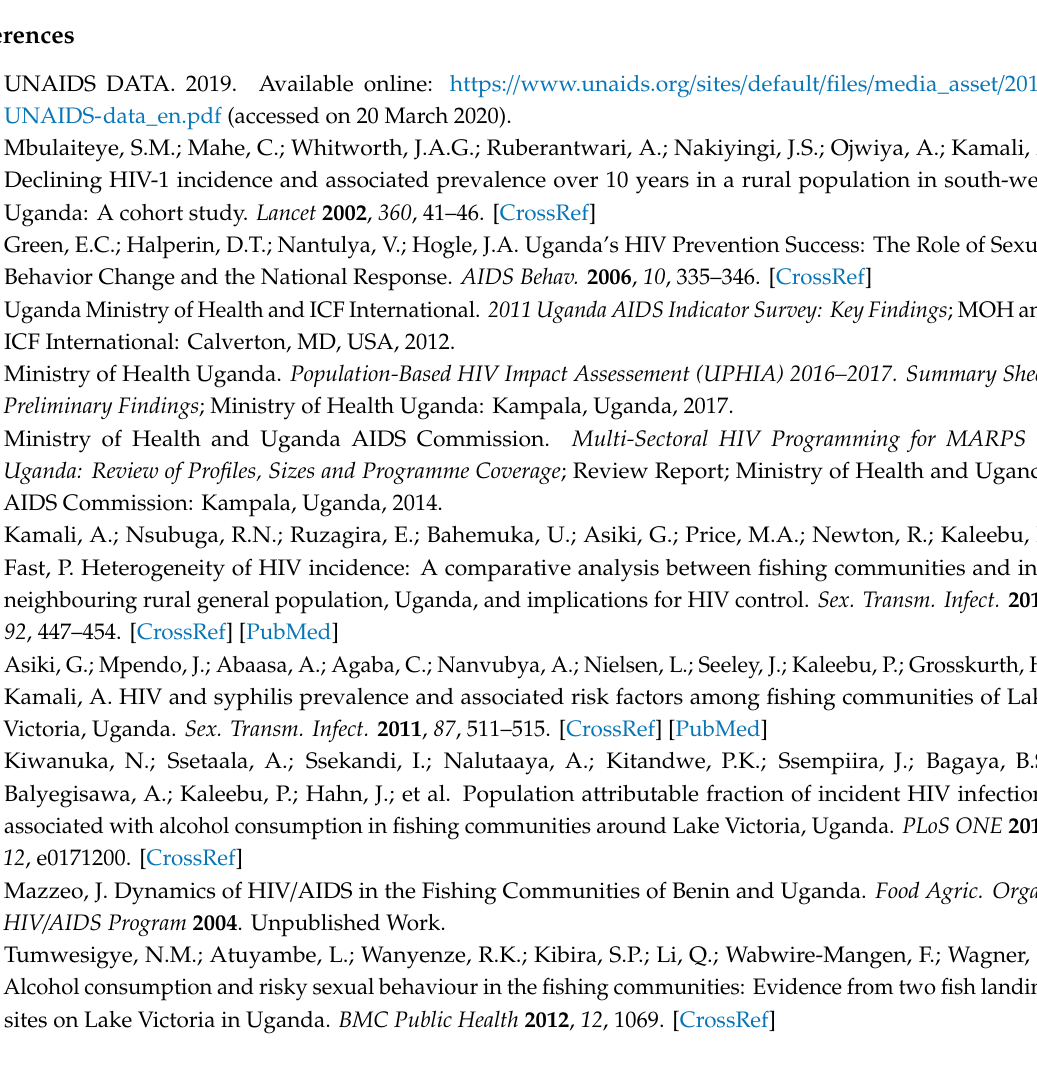
Table S1: Gender ratios shown at higher resolution for di ff erent cluster